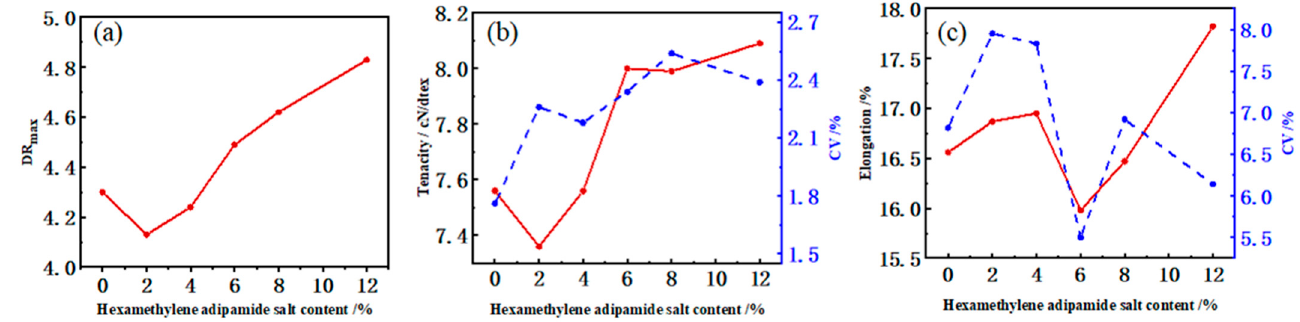
Figure 2. The DR max ( a ) of PA6 and CoPAs as-spun fibers and mechanical properties ( b , c ) of PA6 and CoPAs HTs.